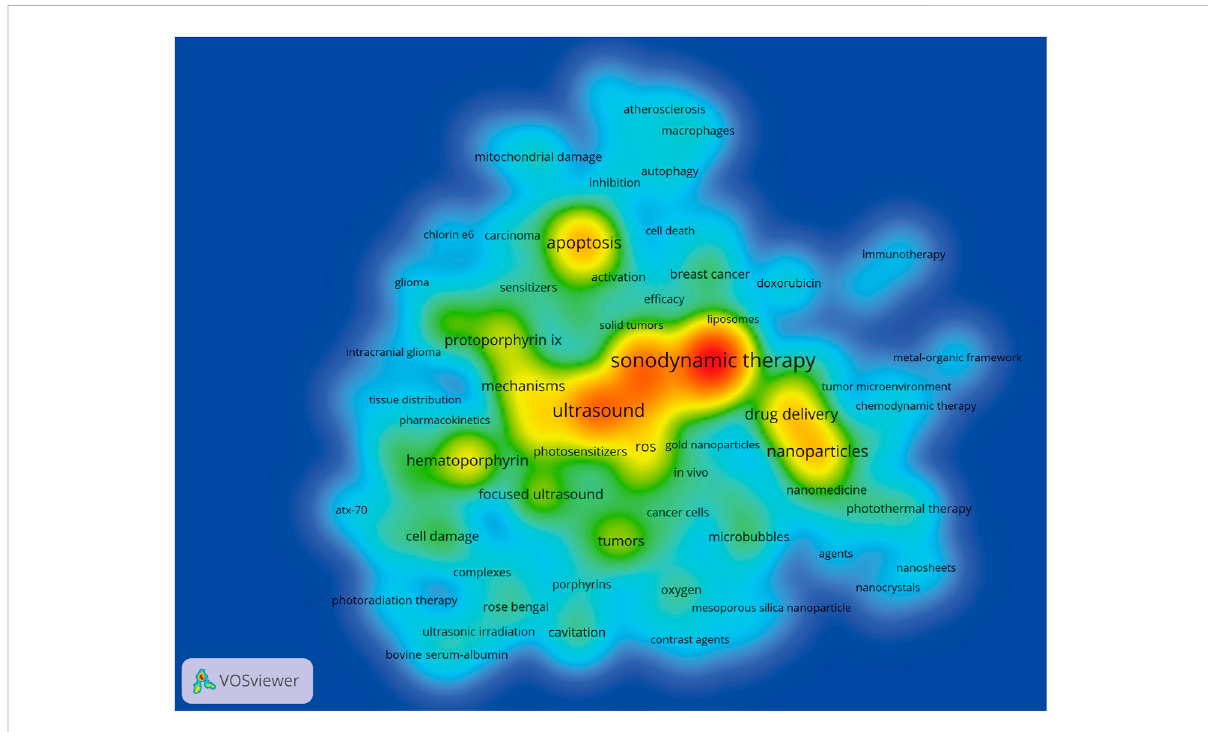
FIGURE 5 Heatmap of keywords co-occurrence analysis generated by using VOSviewer. The size and color depth of words were positively related to the co-occurrence frequency.